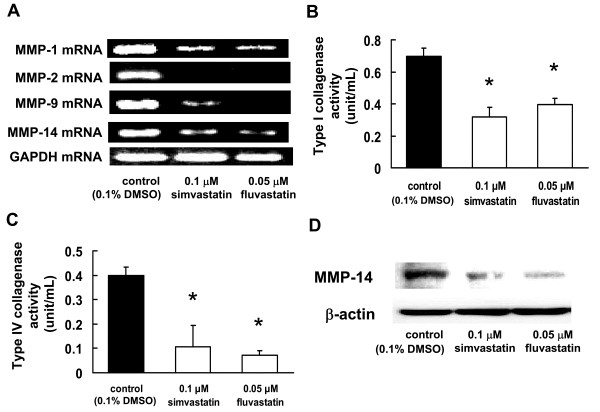
Inhibitory effects of statins on the mRNA expressions and protein activities of MMPs. B16BL6 cells were treated with 0.05 μM fluvastatin or 0.1 μM simvastatin for 3 d. (A) Equal amounts of total RNA were reverse-transcribed to generate cDNAs that were used for PCR analysis of the mRNA expressions of MMPs in B16BL6 cells. (B, C) Activities of (B) type I collagenase (MMP-1) and (C) type IV collagenases (MMP-2 and MMP-9) in B16BL6 cells. Conditioned media were harvested, and the type I and type IV collagenase activities were measured by FITC-conjugated type I and type IV collagen breakdown assays, respectively. The results are representative of 5 independent experiments. (D) Image showing a western blot of the MT1-MMP protein expression.